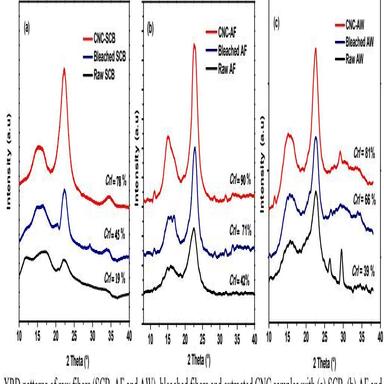
XRD patterns of raw fibers (SCB, AF and AW), bleached fibers and extracted CNC samples with (a) SCB, (b) AF and (c) AW